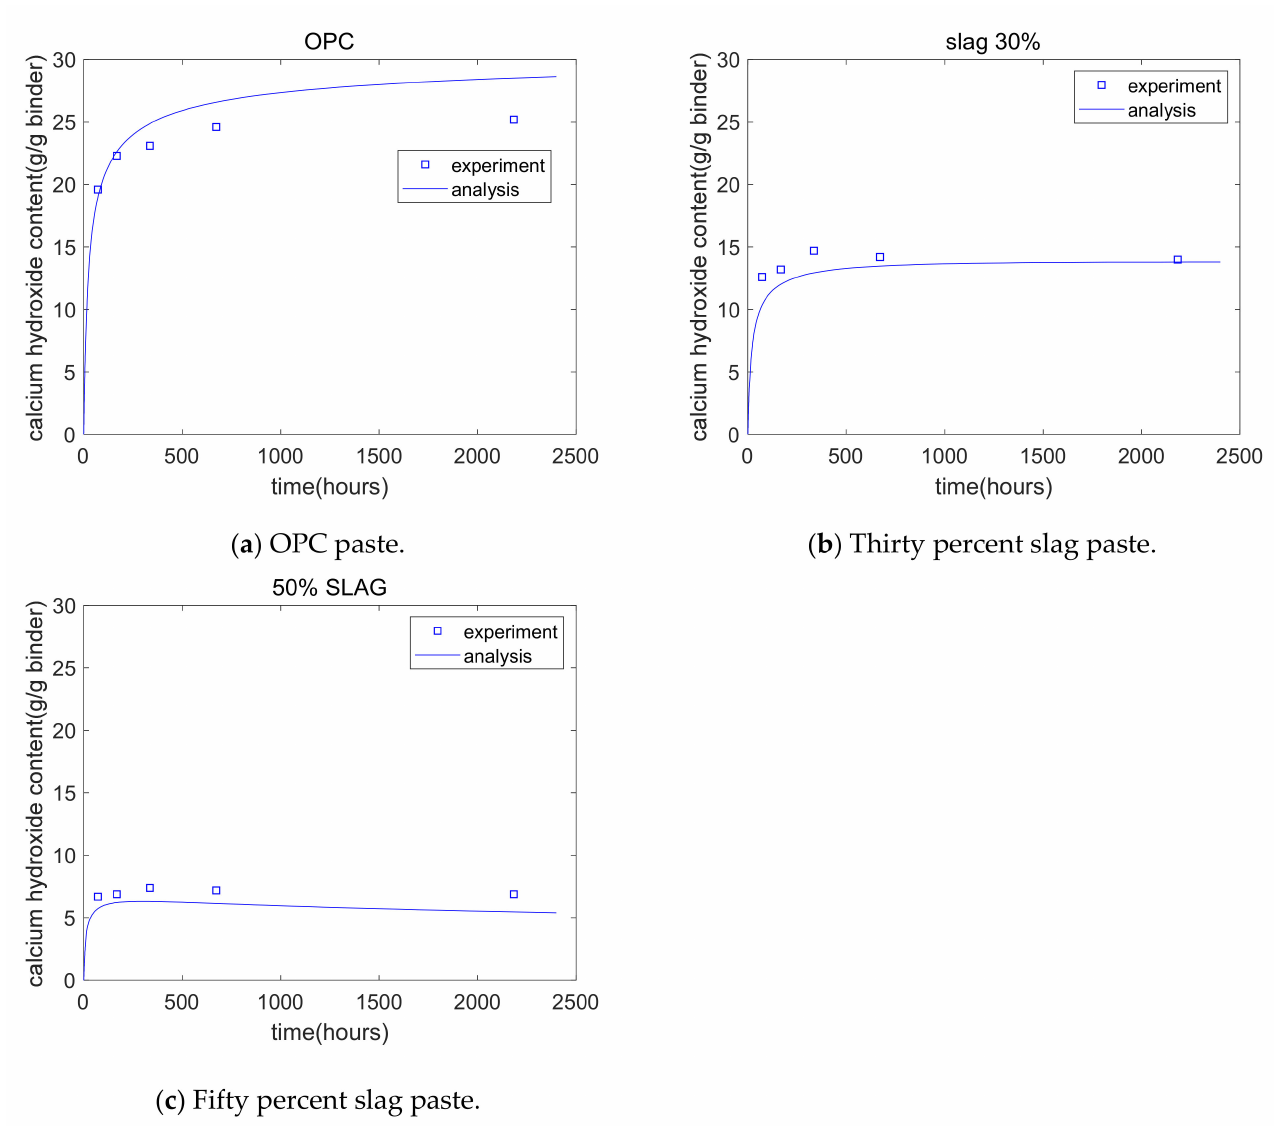
Figure 8. Calcium hydroxide analysis